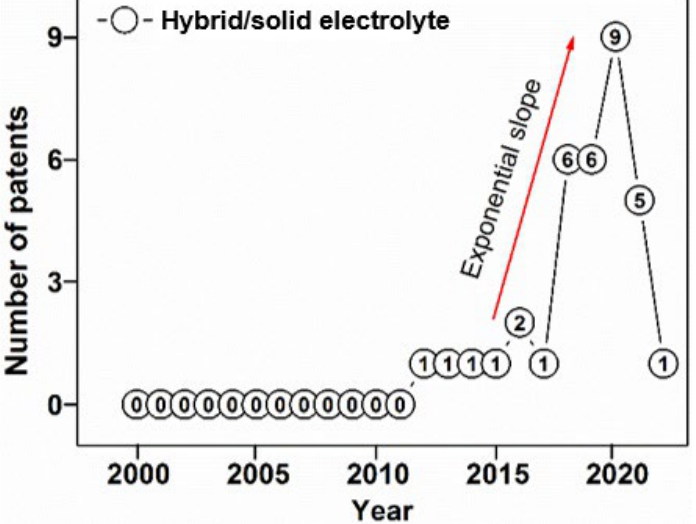
Figure 10. Progression of patent applications on hybrid (inorganic-polymeric)/solid electrolytes in 2000–2020.